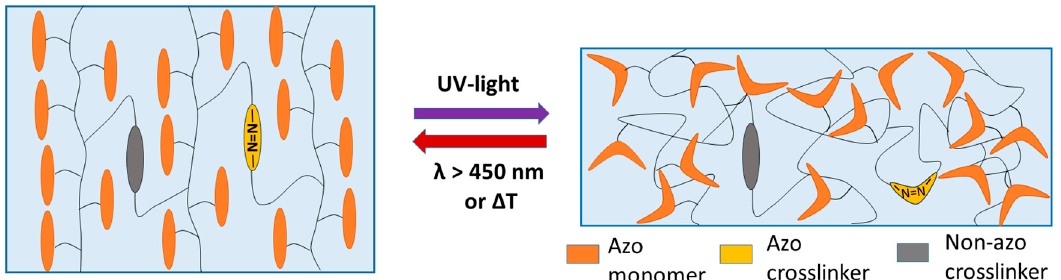
Figure 1. Schematic drawing of an azo-liquid crystalline elastomer’s (LCE’s) photoactuation with an azo and a non-azo crosslinker. Compared to the latter, the azo crosslinker can contribute to the chemical modification of the LC material.